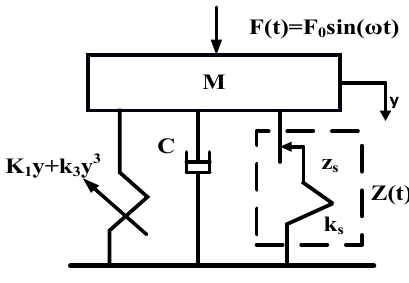
Figure 10. Hysteretic oscillator model.